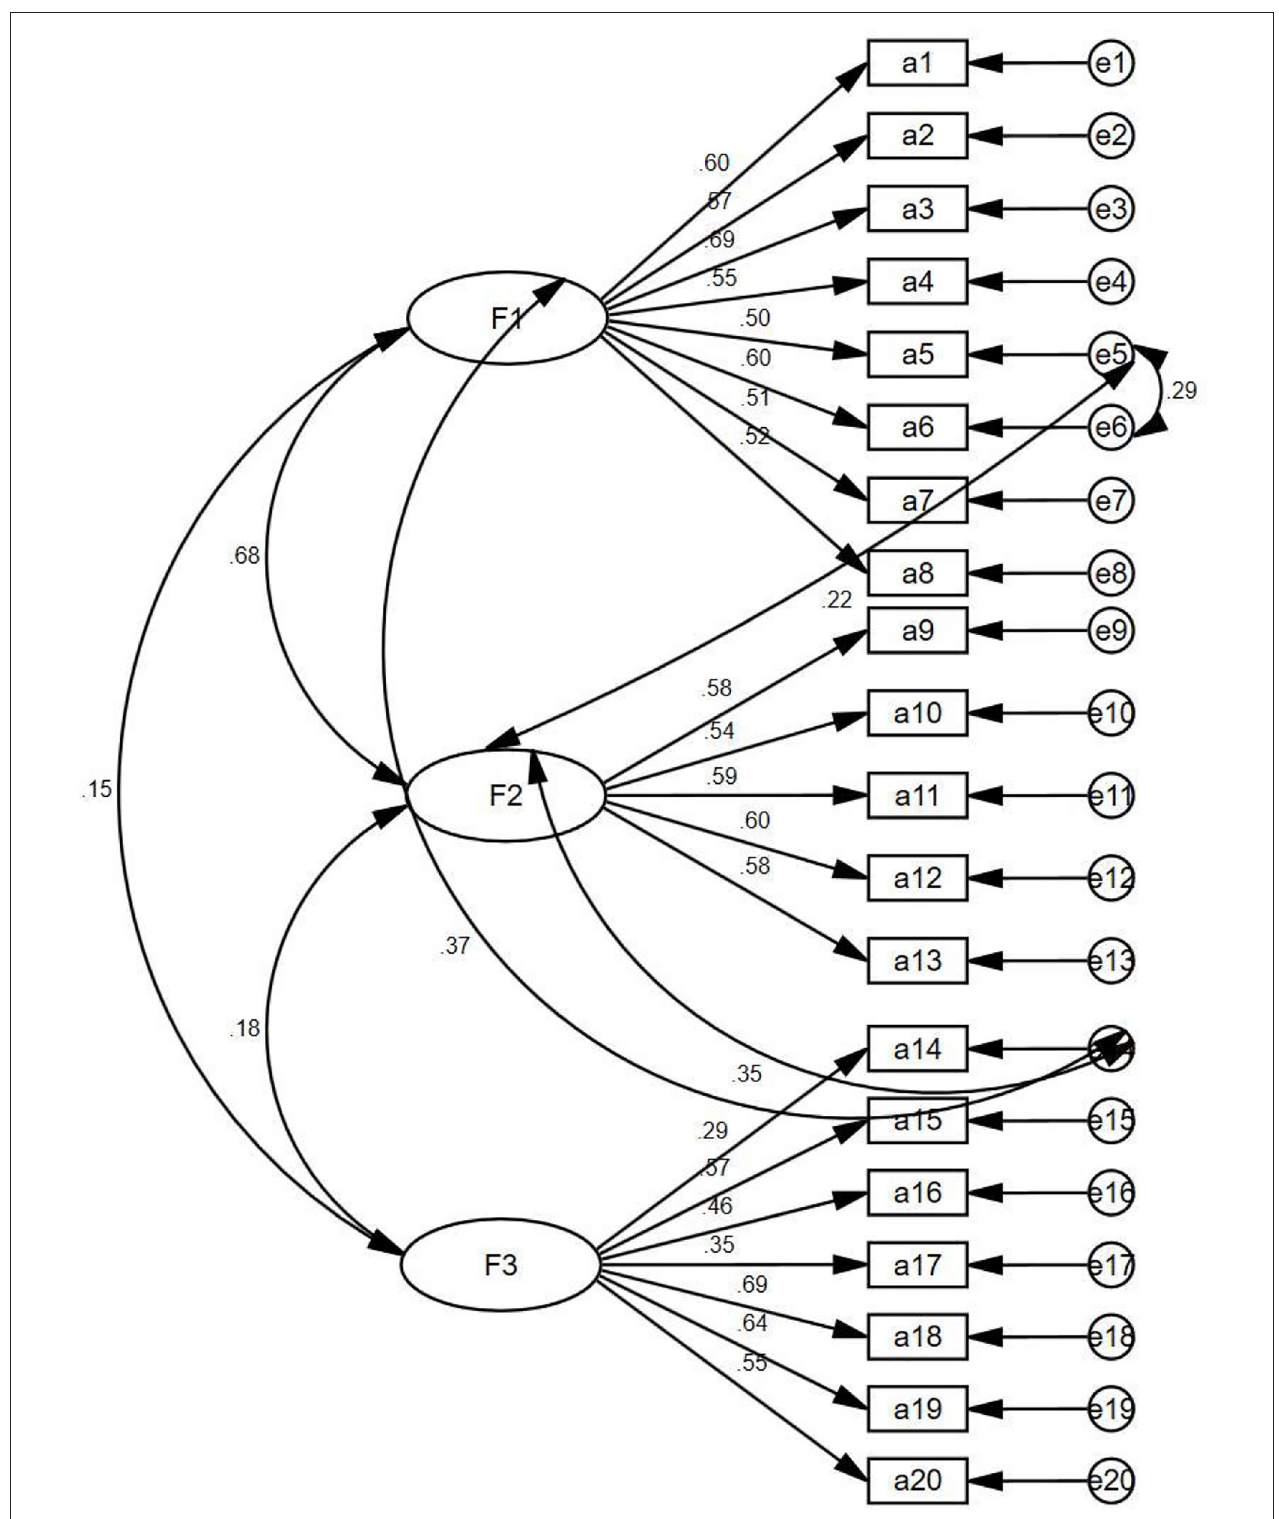
FIGURE 1 | Standardized three-factor structural model of the SASMIN ( n = 501).